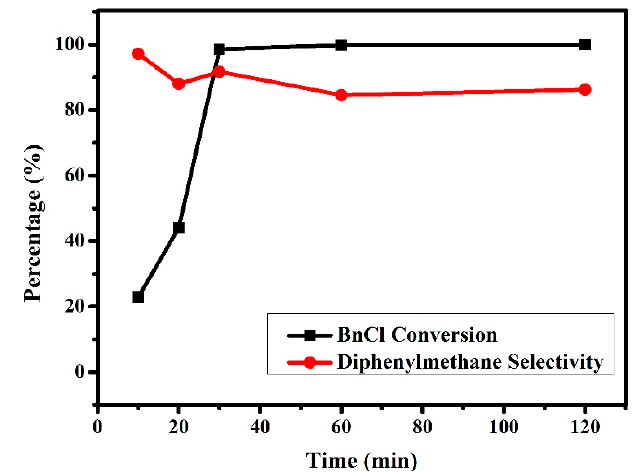
Figure 1. The effects of reaction time on the Friedel–Crafts alkylation reaction of p-xylene with BnCl (under 20 mole % 5c, a reaction temperature of 80 °C, and a molar ratio of p-xylene:BnCl = 2:1).